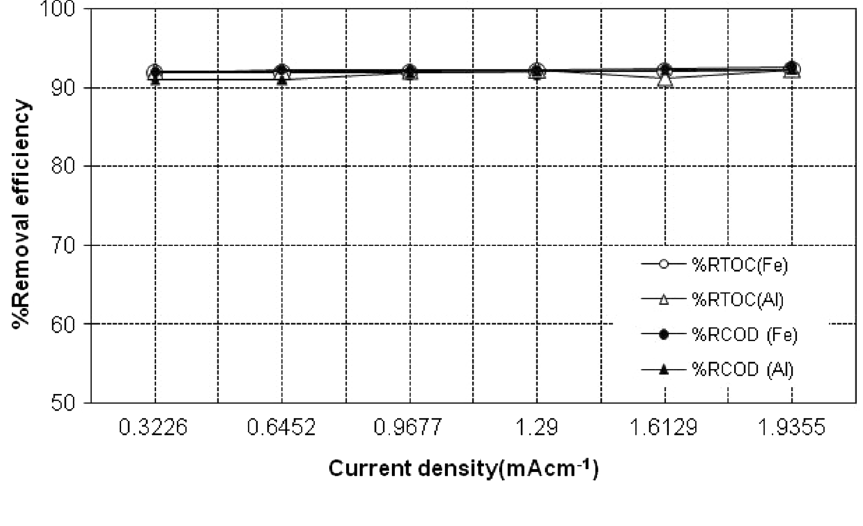
Fig. 5 The effect of elec- trolysis time on the COD and TOC removal by Fe and Al electrode removal efficiency ( i = 0.3226 mA/ cm 2 ; C o,COD = 399,800 mg/L; C o,TOC = 98,120 mg/L; NaCl = 1 g/L; pH 6; T = 298 K; agitation speed = 120